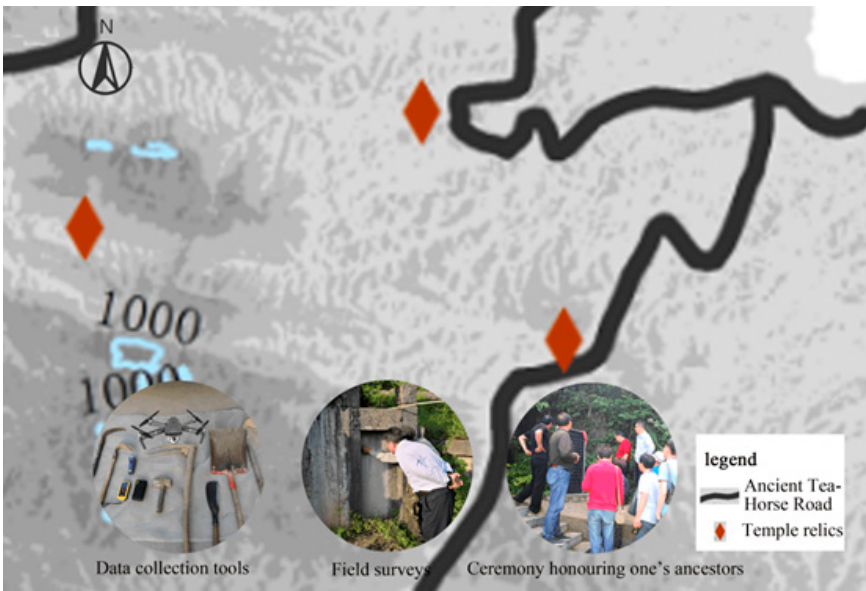
Figure 4. Field survey and data collection scenarios.